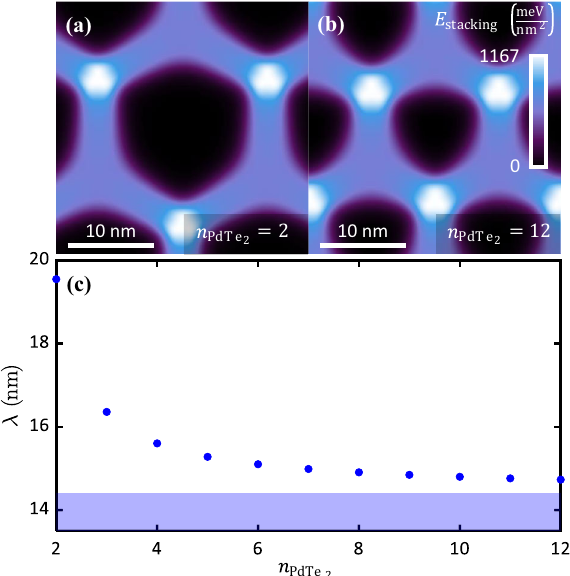
FIG. 3. Modeling of thickness-dependent moir´e superlattice in PdTe 2 = Bi 2 Se 3 . (a),(b) Moir´e superlattice after mechanical relaxation visualized by the stacking energy density for two (a) and 12 (b) PdTe 2 layers on bulk Bi 2 Se 3 . (c) Moir´e periodicity λ as a function of the number of PdTe 2 layers. The blue region marks the range of accessible moir´e period values without isotropic global strain. The relaxation calculations reveal enhanced relaxation and expansion of the moir´e periodicity in the thin PdTe 2 layer limit. All considered cases assume no twist between the PdTe 2 and the Bi 2 Se 3 . See calculation details in Appendix